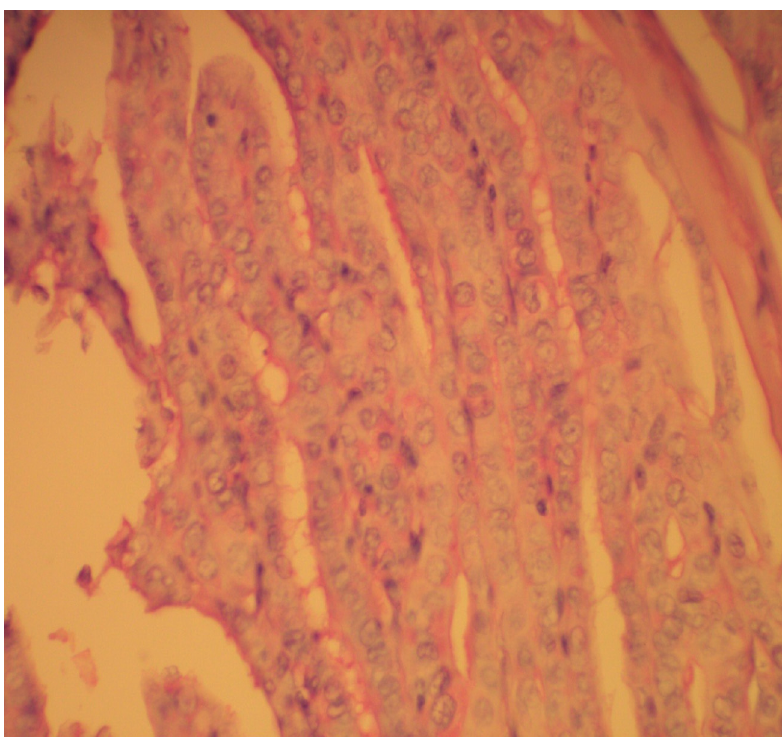
Figure 1: Nuclear features of papillary thyroid carcinoma, ground glass appearance, intranuclear grooves, nuclear crowding, and overlapping (x400).